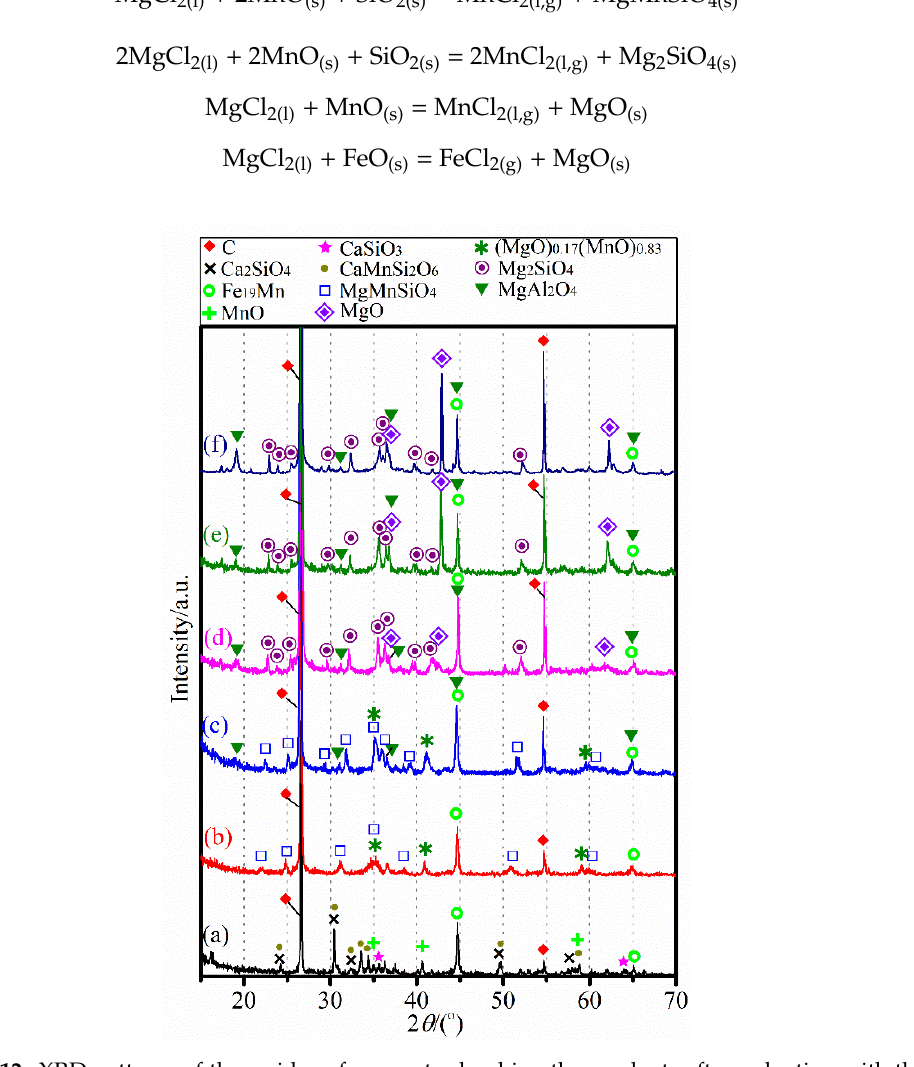
Figure 12. XRD patterns of the residues from water-leaching the products after reduction with the addition of 20 wt% CaCl 2 and various amounts of MgCl 2 (a, 0 wt%; b, 10 wt%; c, 20 wt%; d, 30 wt%; e, 40 wt%; f, 50 wt%).